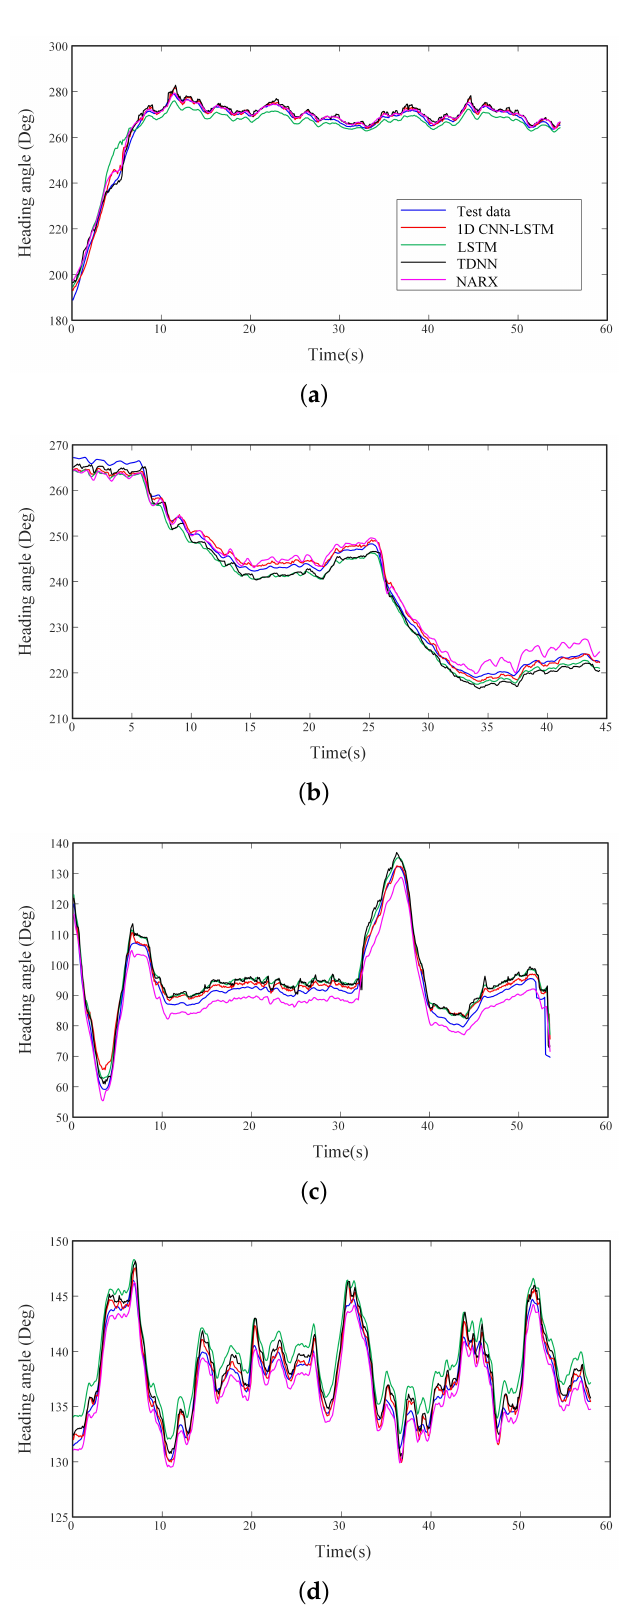
Figure 8. Comparison of the heading angle by 1D CNN-LSTM network, LSTM network, NARX network and TDNN network at different sea level. ( a ) Level 1 sea condition. ( b ) Level 2 sea condition. ( c ) Level 3 sea condition. ( d ) Level 4 sea